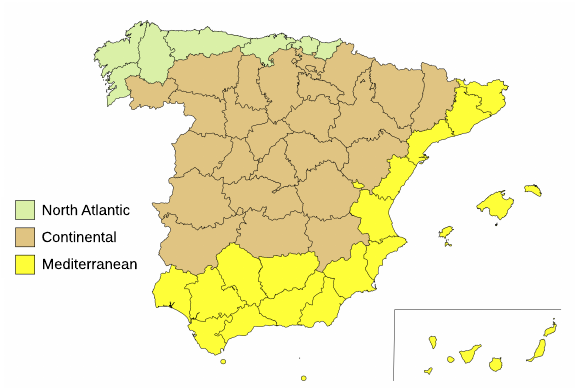
Figure 2. Geographic distribution of climatic zones in